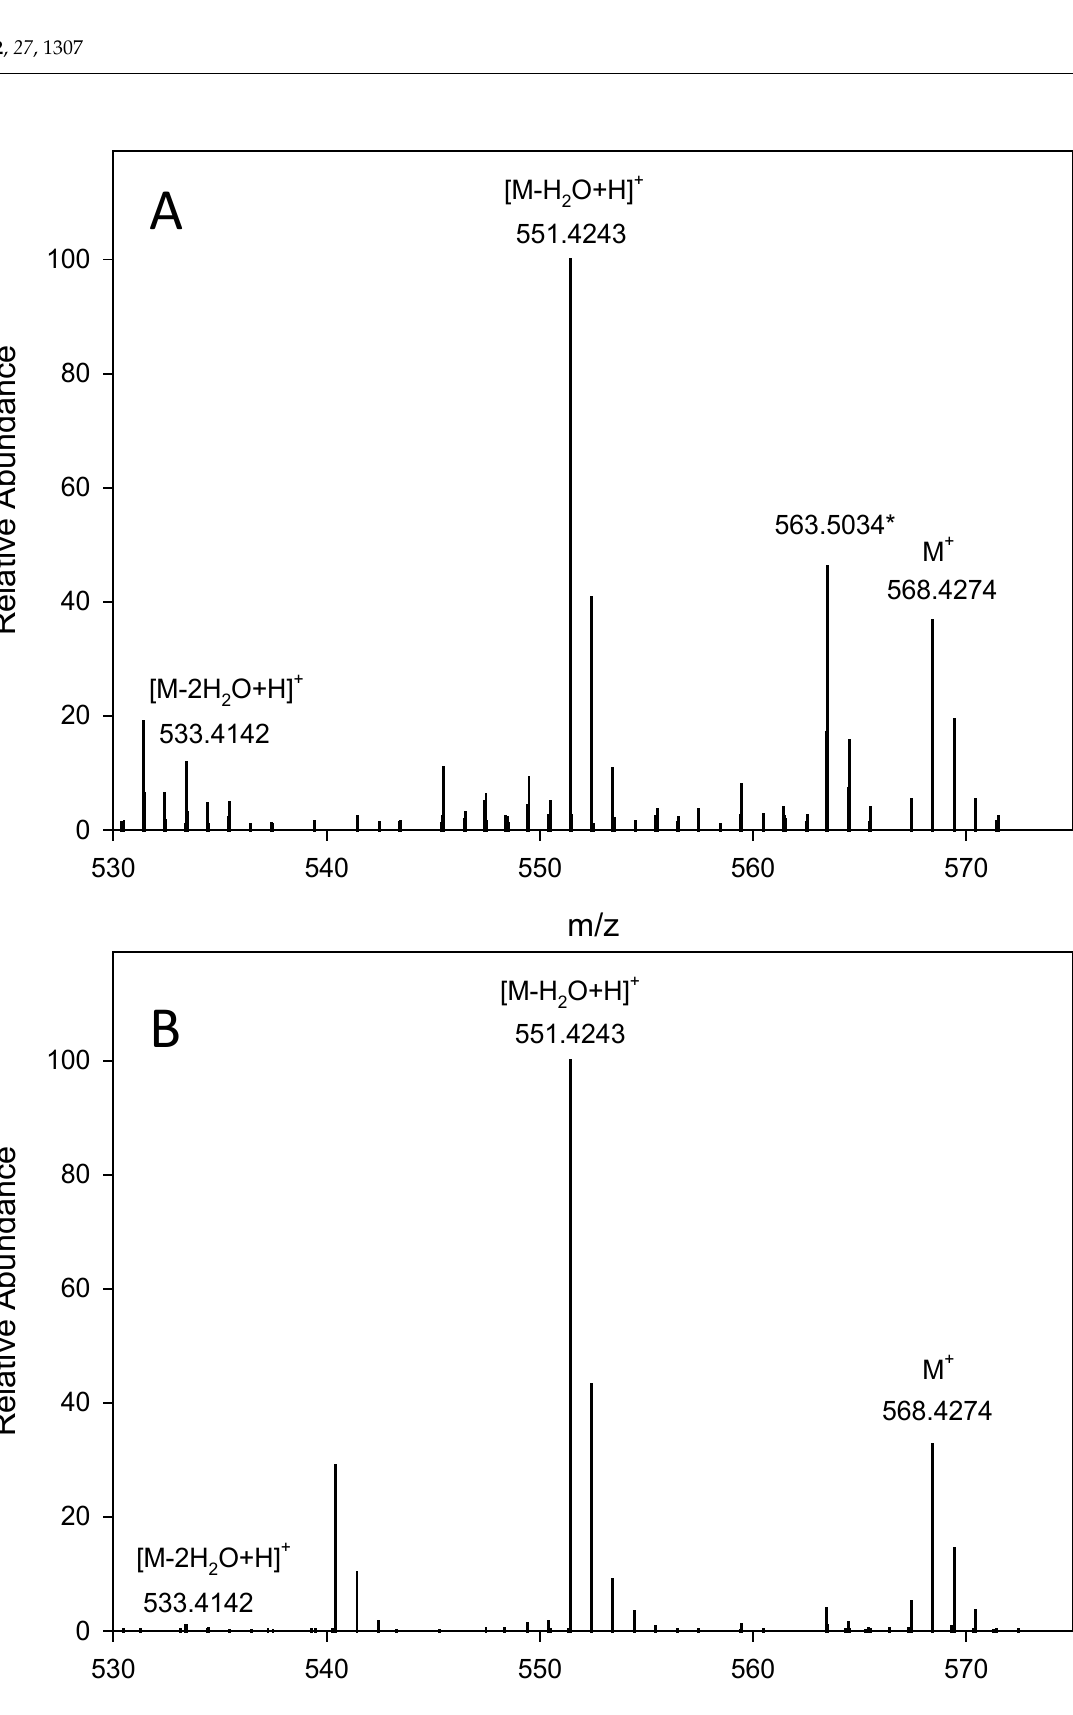
Figure 2. MS spectra of all- trans -lutein in two positive ionization modes, ( A ) APCI and ( B ) ESI. * Major non-carotenoid peaks.